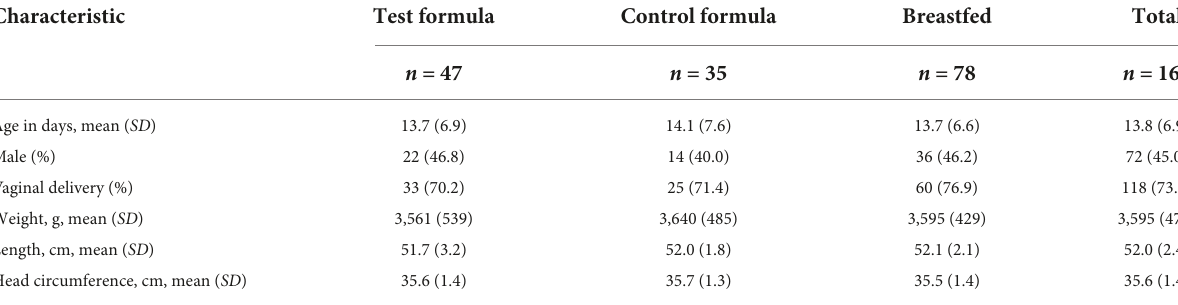
TABLE 3 Demographic and baseline characteristics (PP population).